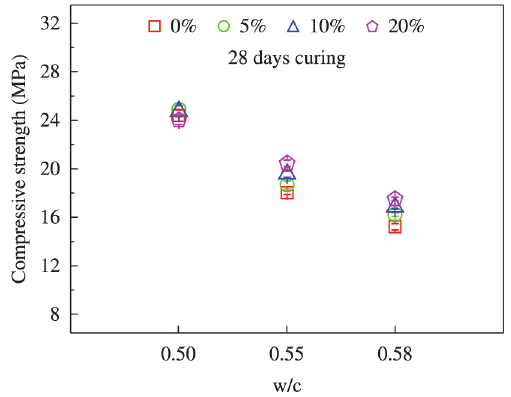
Figure 8. Compressive strength as a function of the w/c ratio after 28 days of